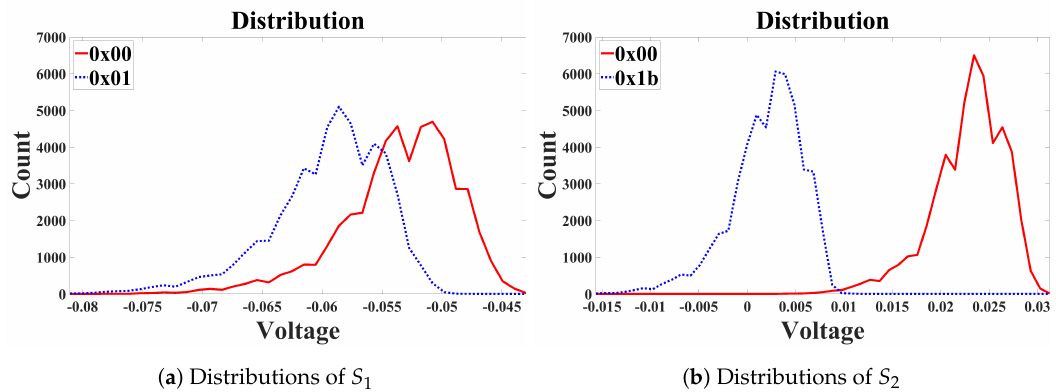
Figure 3. Distributions of power consumption that occurs when storing S 1 and S 2